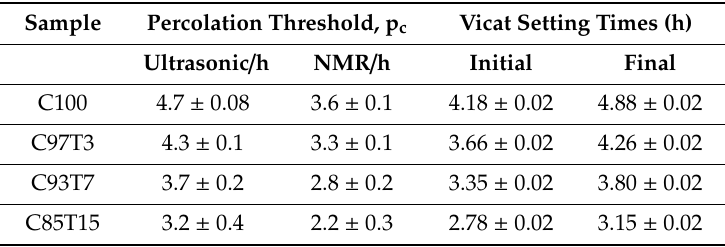
Table 1. Percolation parameters ( p c ) obtained from fitting NMR and ultrasonic data to Equations (8) and (9) and weighted standard deviation. Vicat measurements with uncertainty